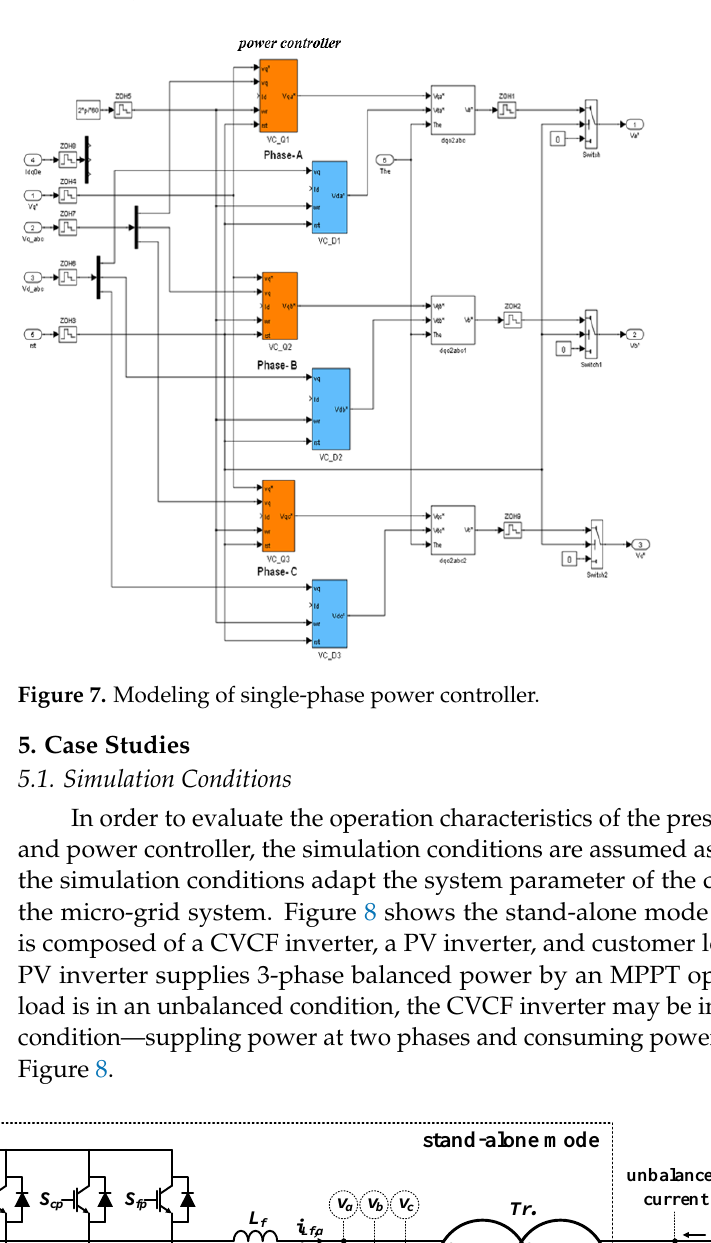
Figure 6. Modeling of single-phase voltage controller.